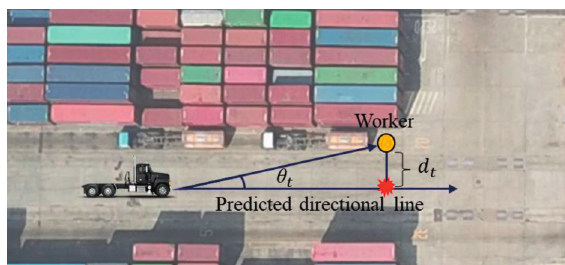
Figure 2: Illustration of the distance between the tractor’s pre- dicted directional line and a